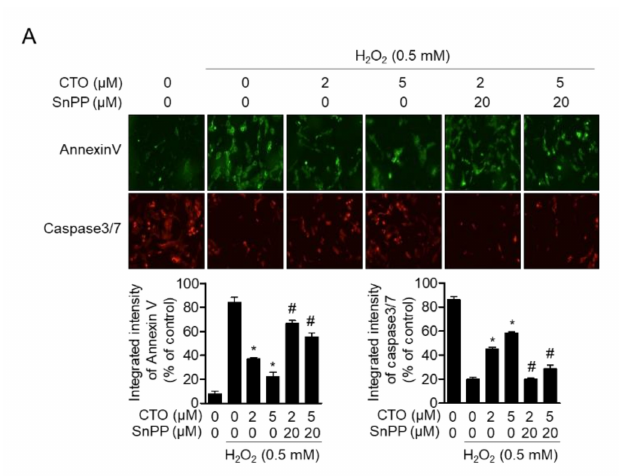
Figure 8. Enhanced HO-1 by CTO shows a protective e ff ect from apoptosis induced by H 2 O 2 in SW1353 cells. ( A ) SW1353 cells were pre-treated with or without 20 µ M SnPP for 1h. Then cells were treated with the indicated concentration of CTO (2 or 5 µ M) for 6 h, and incubated with 0.5 mM H 2 O 2 for 2 h. Apoptotic cells were evaluated by staining with caspase 3 / 7. Reagents using IncuCyte imaging system. * p < 0.05 vs. only H # p < 0.05 vs. only CTO treated 2 O 2 treat group;